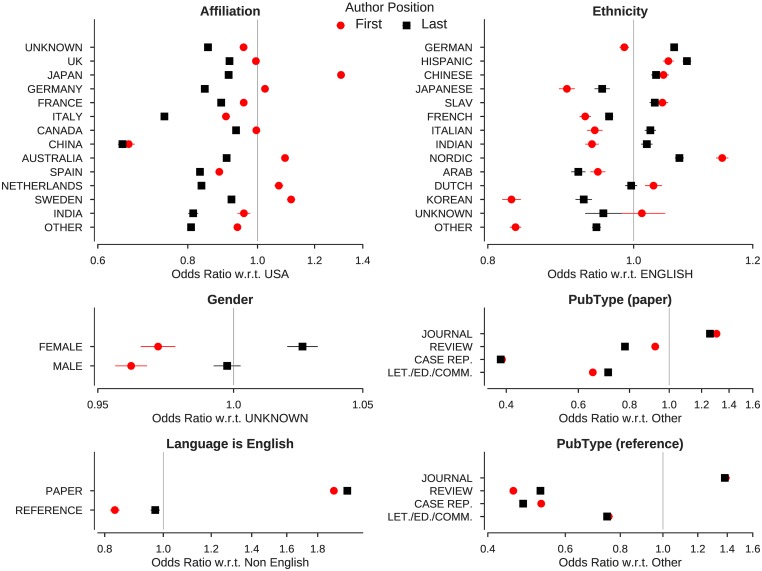
Change in odds with respect to mentioned values of self-citation for select predictors of models of first and last authors.Error bars indicate 95% confidence intervals. Among other interesting points, note that the likelihood of self-citation is least for last authors with non-USA affiliation, implying that self-citing is customary among USA authors. X-axis is on log scale.